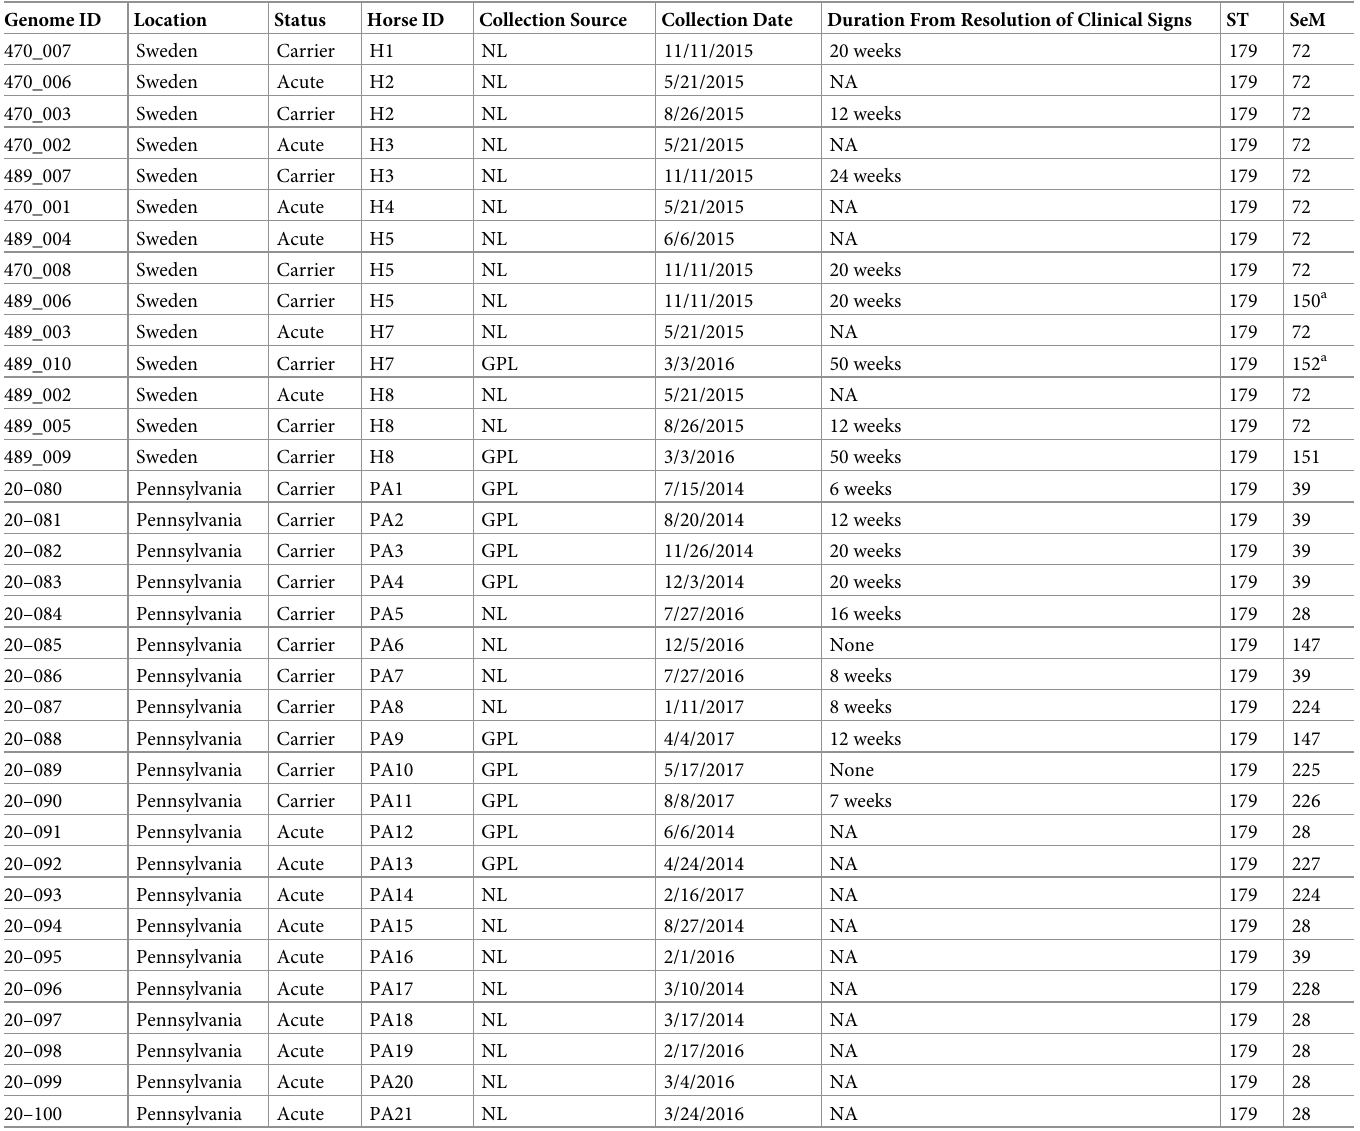
Table 1. Description of the 14 SEE isolates from Sweden and the 21 SEE isolates from